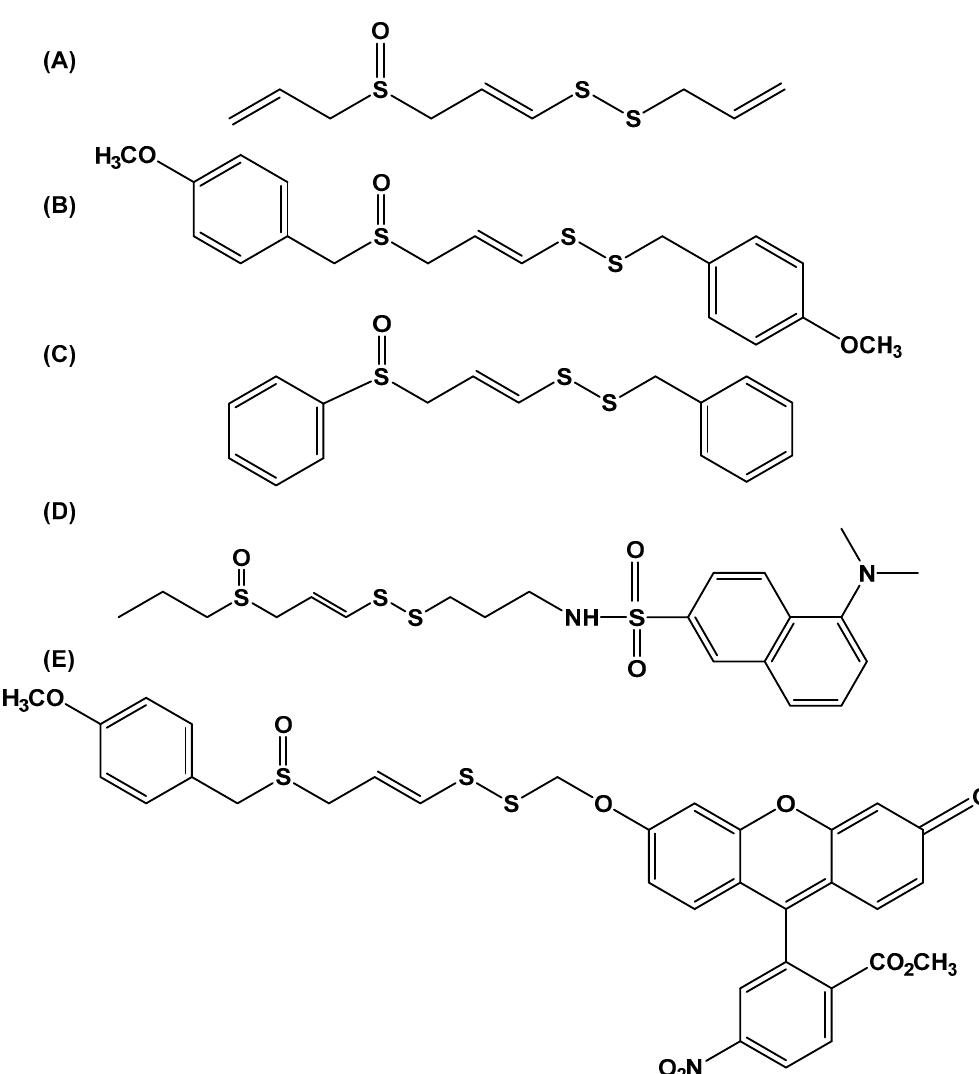
Figure 4. ( A ) Ajoene has inspired derivatives synthesis like ( B ) (E,Z )-1,8-( Bis-para